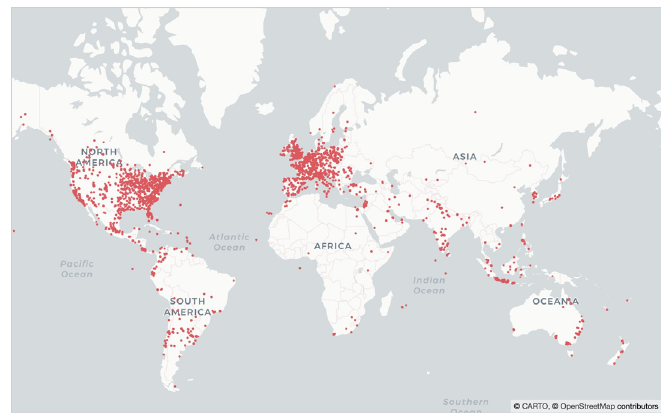
Figure 2. Worldwide distribution of complaints.